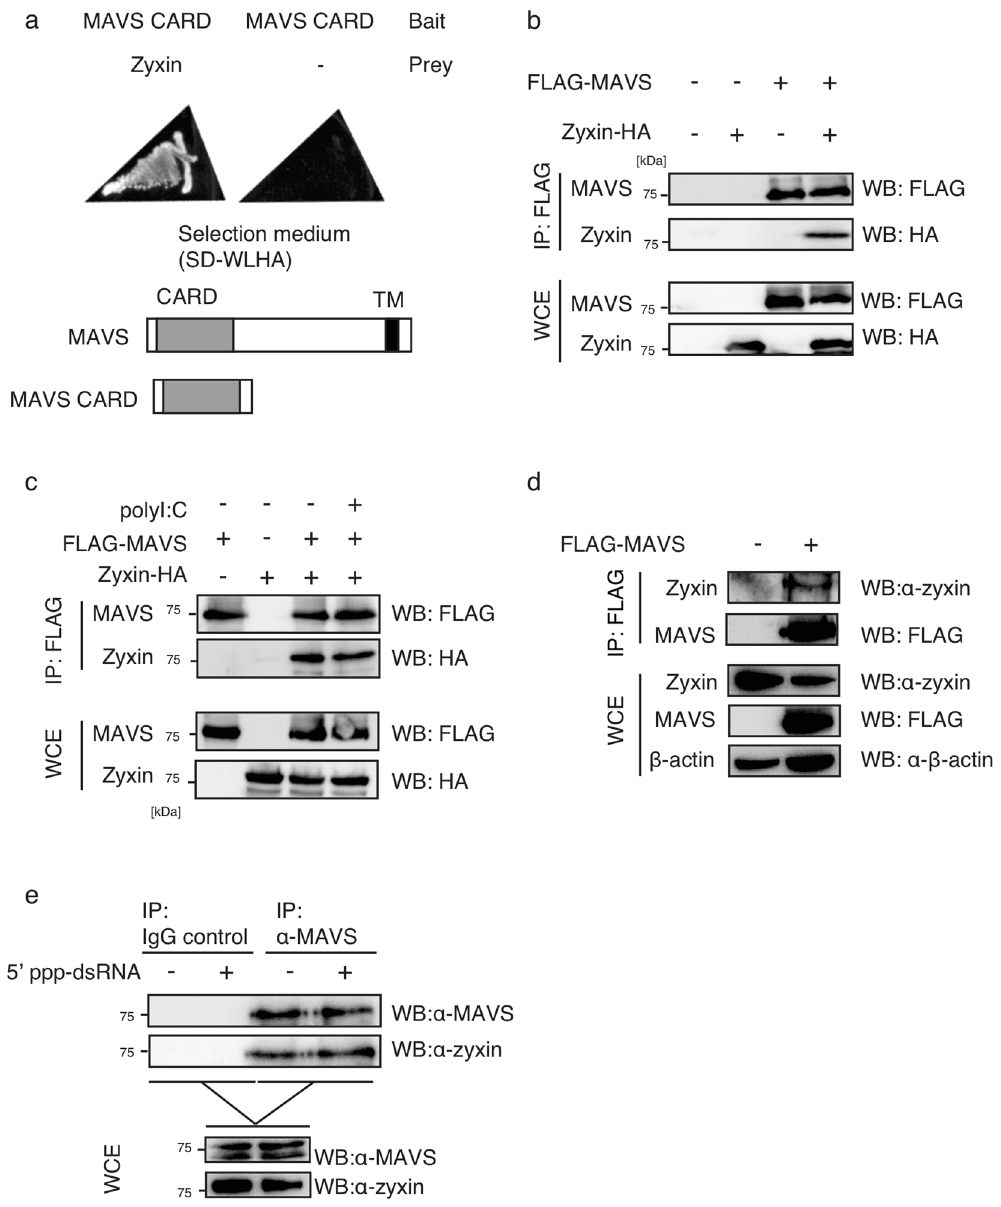
Figure 1. Zyxin binds to MAVS. ( a ) A plasmid carrying the Gal4 DNA-binding domain fused to a MAVS CARD fragment (Bait) was transformed into AH109 yeast cells either with a plasmid carrying the Gal4 activation domain fused to zyxin, or with empty vector (Prey). The transformed cells were inoculated on to selective medium (SD-WLHA). The yeast cells grew on the selective plates when the 2 proteins interacted with each other. ( b ) FLAG-MAVS and/or Zyxin-HA vectors were transfected into HEK293FT cells for 24 h, then cells were lysed with lysis buffer (whole cell extract, WCE). The proteins were immunoprecipitated with an anti-FLAG antibody and subjected to SDS-PAGE. The proteins were detected by western blotting (WB) with the indicated antibodies (against HA and FLAG). ( c ) HEK293FT cells expressing FLG-MAVS and Zyxin-HA were mock-transfected or transfected with polyI:C for 6 h, and whole cell extract (WCE) was subsequently prepared. WCE were used for immunoprecipitation with an anti-FLAG antibody, and immunoprecipitates were subjected to SDS-PAGE. The proteins were detected by WB with the indicated antibodies. ( d ) FLAG-MAVS or empty vector was transfected into HEK293FT cells for 24 h. Proteins from WCEs were immunoprecipitated with anti-FLAG antibody. The proteins were subjected to SDS-PAGE. Endogenous zyxin was detected by WB with anti-zyxin antibodies, and other proteins were detected with the indicated antibodies. ( e ) HEK293FT cells were mock-transfected or transfected with 5 ′ -pppRNA for 6 h. Proteins in WCEs of HEK293FT cells were immunoprecipitated with anti-MAVS antibody or control IgG. Immunoprecipitates were subjected to SDS- PAGE, and endogenous proteins were detected with anti-MAVS and anti-zyxin antibodies. The original full blot images for western blotting can be found in Supplemental Fig.